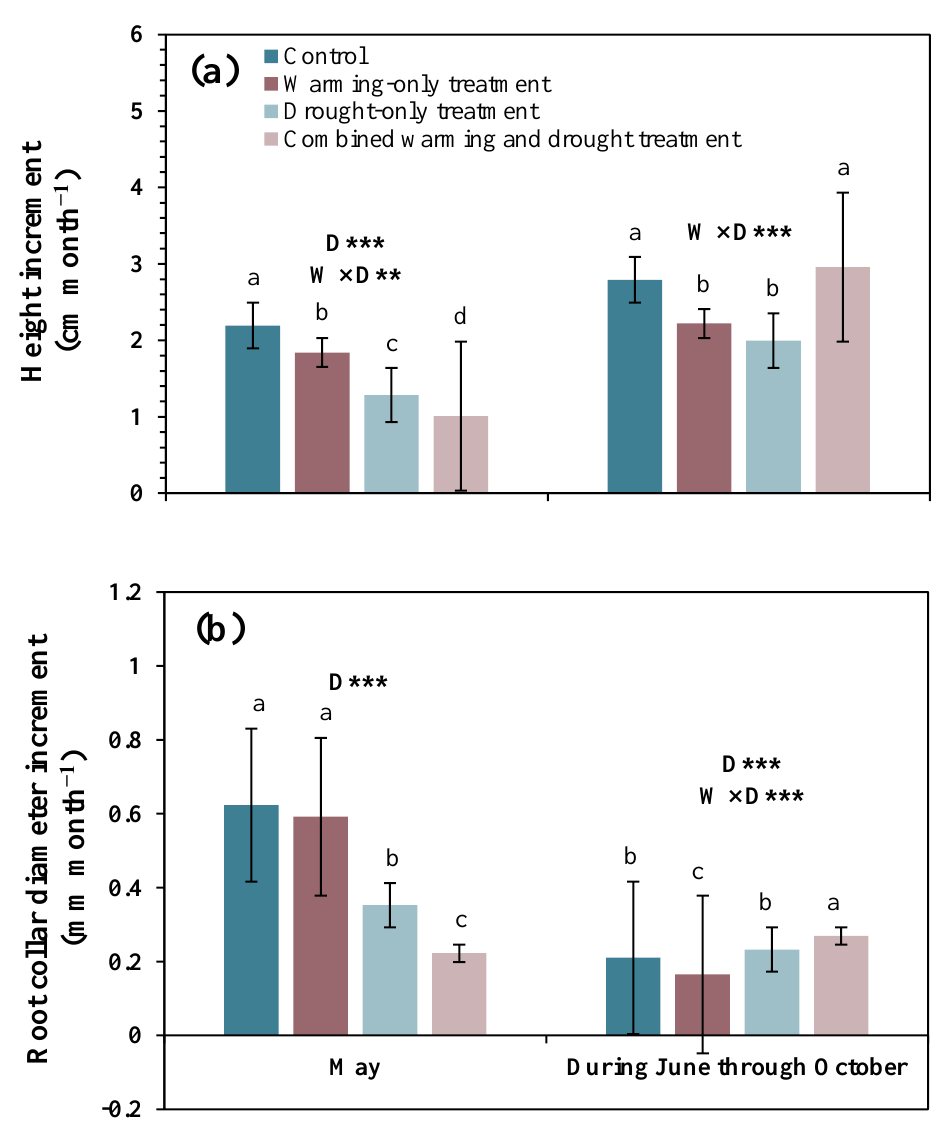
Figure 3. Height increment ( a ) and root collar diameter increment ( b ) of Larix kaempferi seedlings in 2020. Bars with different letters are significantly different among treatments at p < 0.05. Error bars are the standard errors of the means, and asterisks (*) indicate significant differences between the warming and drought treatments (** p < 0.01; *** p < 0.001). W: warming effect; D: drought effect; W × D: interaction effect of warming and